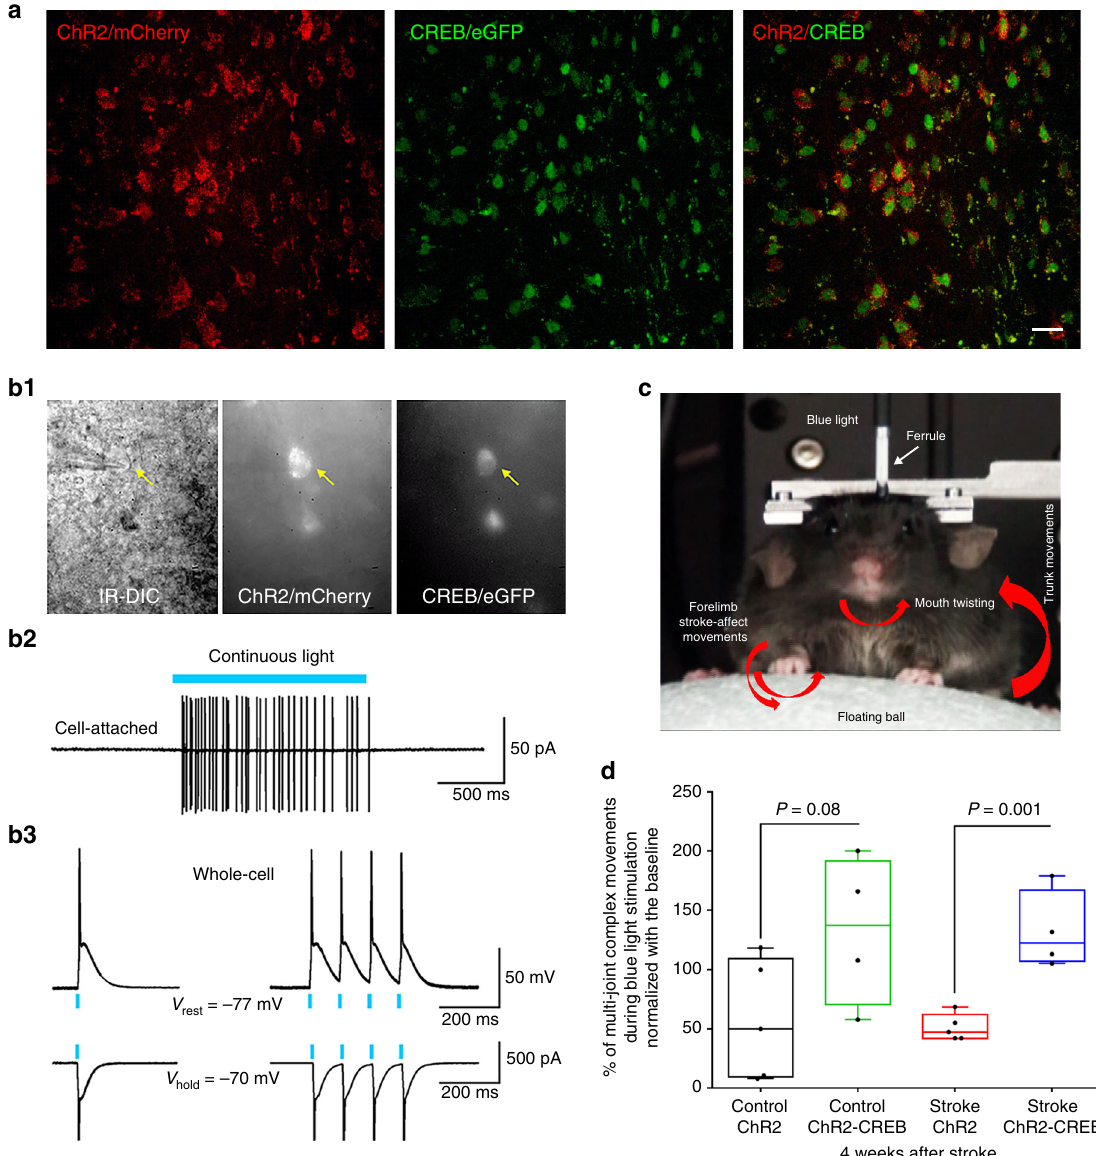
Fig. 4 Lentiviral CREB expression induces greater multi-joint movements after stroke. a Immunohistochemical staining of pyramidal cells (CAMKII α promoter drives expression in pyramidal neurons) in peri-infarct M1 in mice transfected with Lentiviral ChR2-mCherry (left) and lentiviral CREB-eGFP (middle). Right: Co-localization of ChR2 and CREB lentiviruses 4 weeks after stroke, showing nearly complete co-transfection with these two viruses. Scale bar = 50 μ m. b Whole cell recording shows a pyramidal cell (cortex) transfected with lenti-ChR2/mCherry. The cell displayed action potentials (AP) in cell attached mode with blue light (4 mW) and tracked higher frequency light stimulation (10 Hz). At − 70 mV, blue light (4 mW, 0.5 ms pulse) triggers an inward current as expected. c Setup of head- fi xed mouse allowed to run freely on a fl oating Styrofoam ball to detect multi-joint movements during brief pulses of blue light stimulation (pulse length 5 ms, pulse frequency 20 Hz). d Graph shows the percentage of multi-joint complex movements during light stimulation. Stroke + ChR2-CREB produced a signi fi cant increase in multi-joint movements compared with stroke + ChR2-alone 4 weeks after